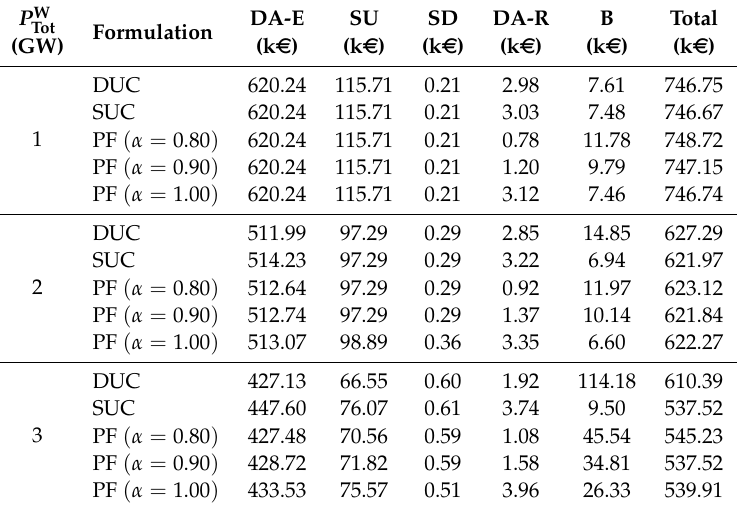
Table 3. Expected costs.